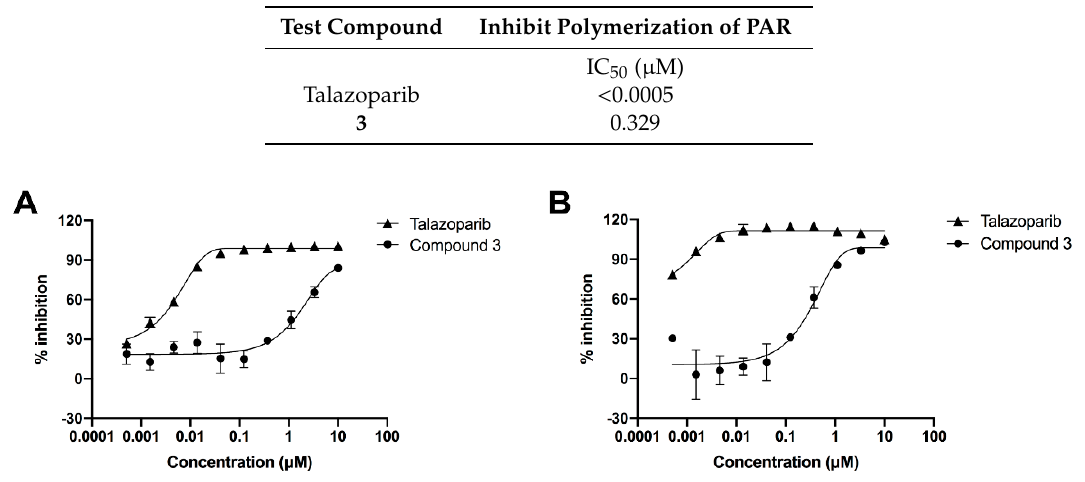
Figure 4. ( A ) Dose–response curve of Talazoparib and compound 3 on PARP-1 enzyme